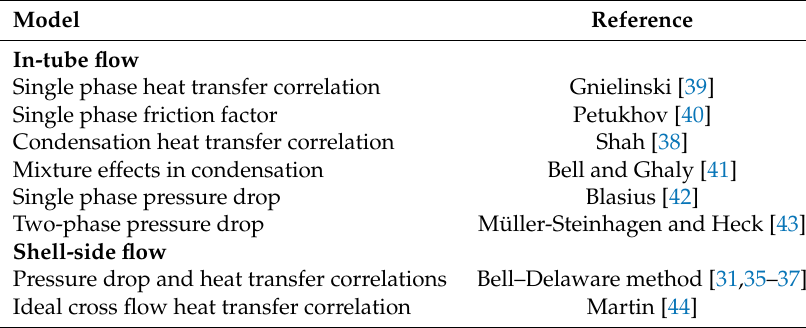
Table 2. Shell-and-tube heat exchanger model overview.